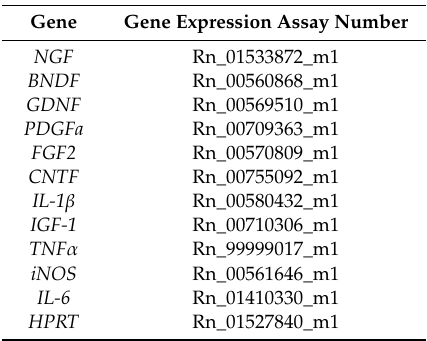
Table 1. Primer used for real-time quantitative polymerase chain reaction